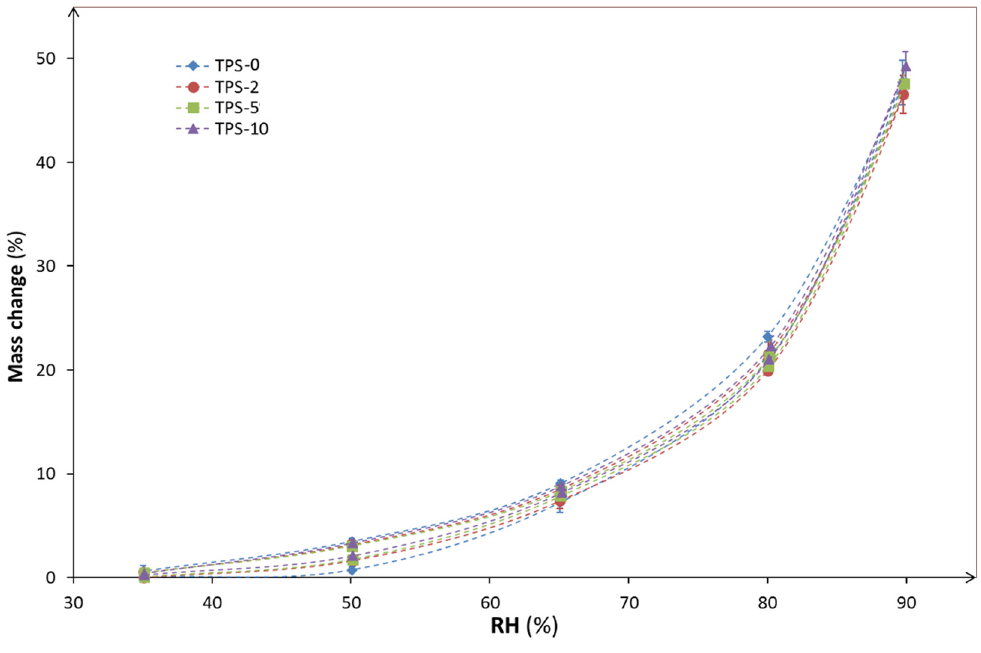
Figure 7. Dynamic vapor sorption curves for TPS/FASEs blends.